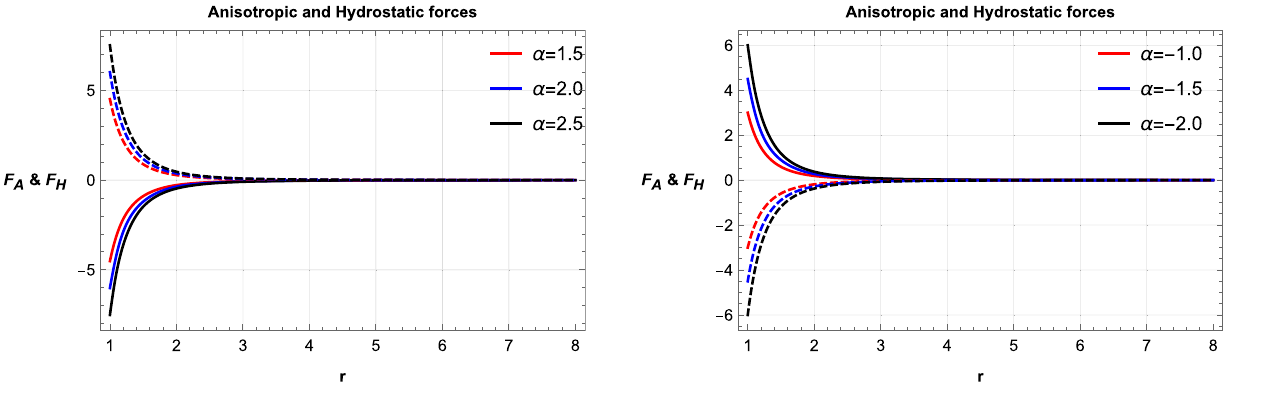
Fig. 17 Hydrostatic (plane lines) and anisotropic (dashed lines) forces for parallel plates with r 0 = 1